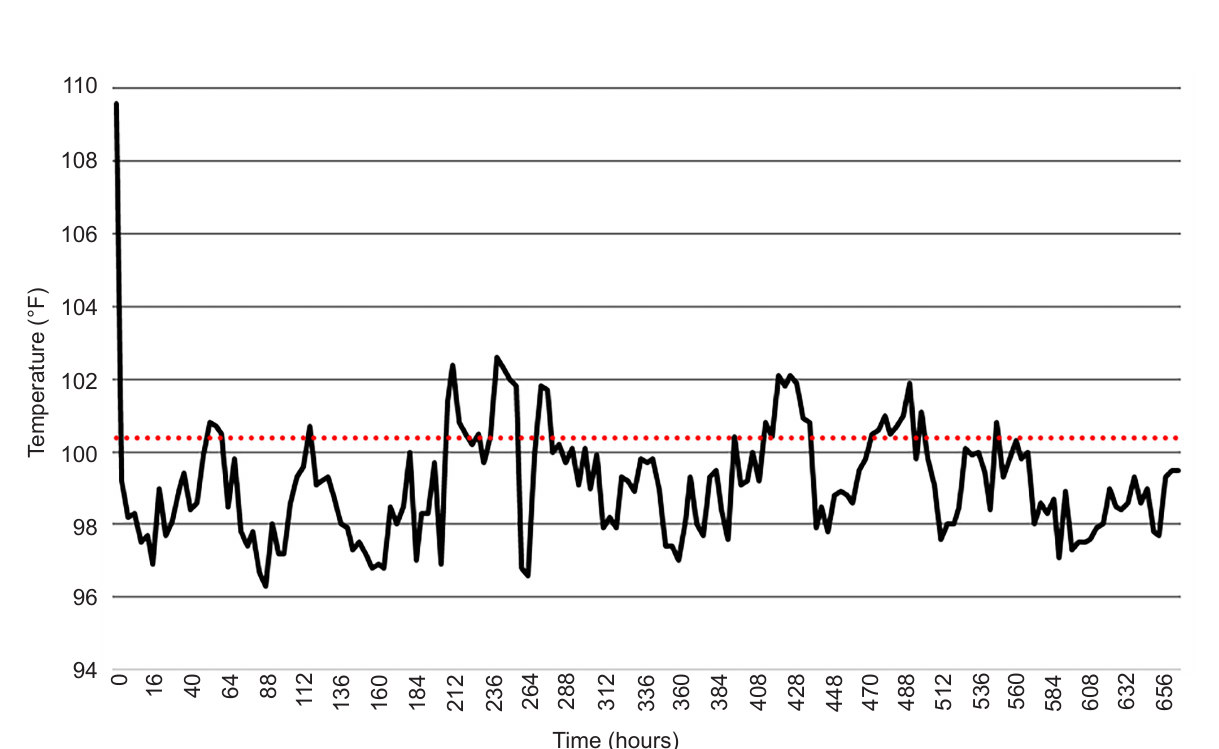
Figure 1. Patient one temperature vs.